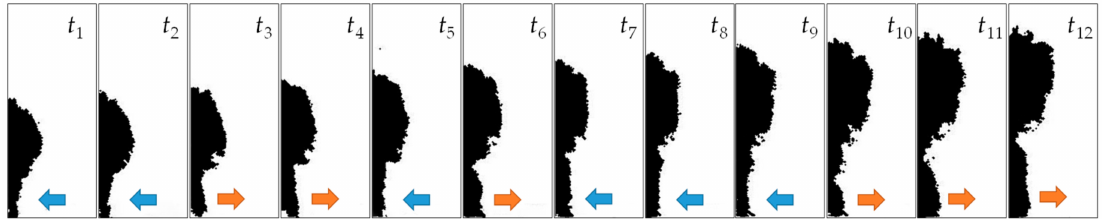
Figure 5. Fluctuations of interface of wave structures ( t 1 = 2.5 ms, ∆ t = 2.5 ms).